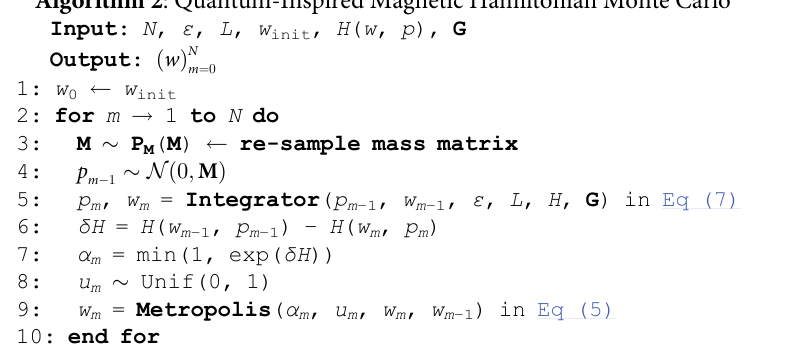
Algorithm 2 : Quantum-Inspired Magnetic Hamiltonian Monte